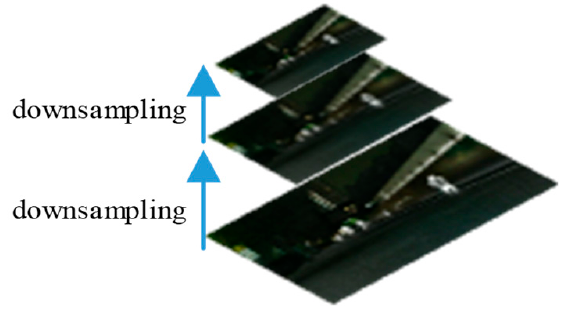
Figure 8. Image pyramid sketch map.